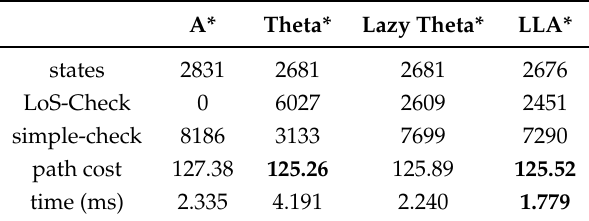
Table 3. Planning results of the maze test